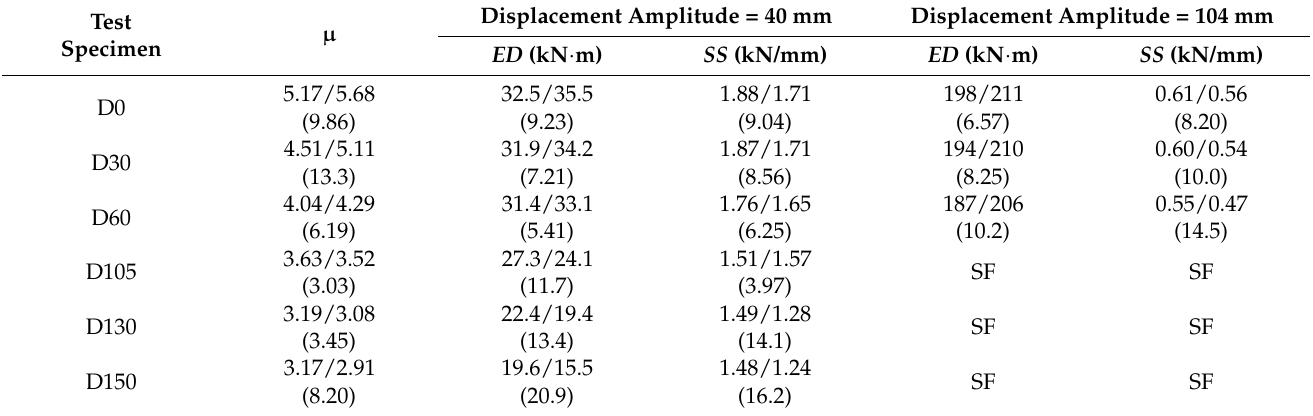
Table 2. Comparisons between the simulation and test